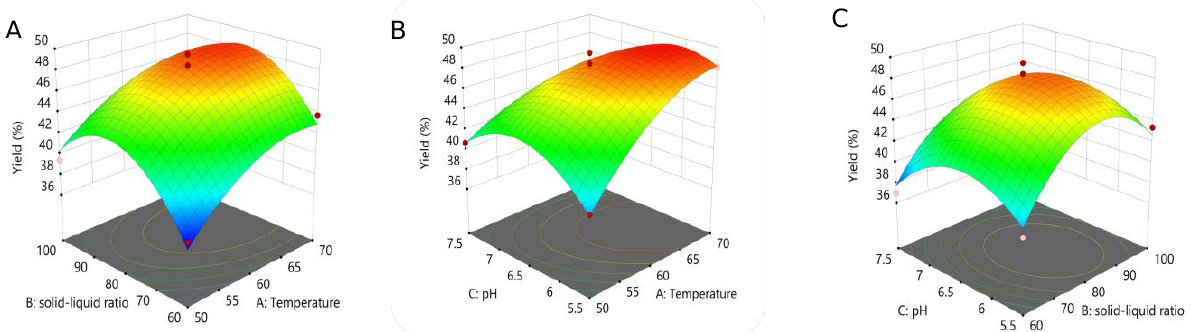
Figure 2. Three-dimensional (3D) response surface plots showing the effect of ( A ) AB, ( B ) AC, and ( C ) BC on the extraction yield of DOPs.